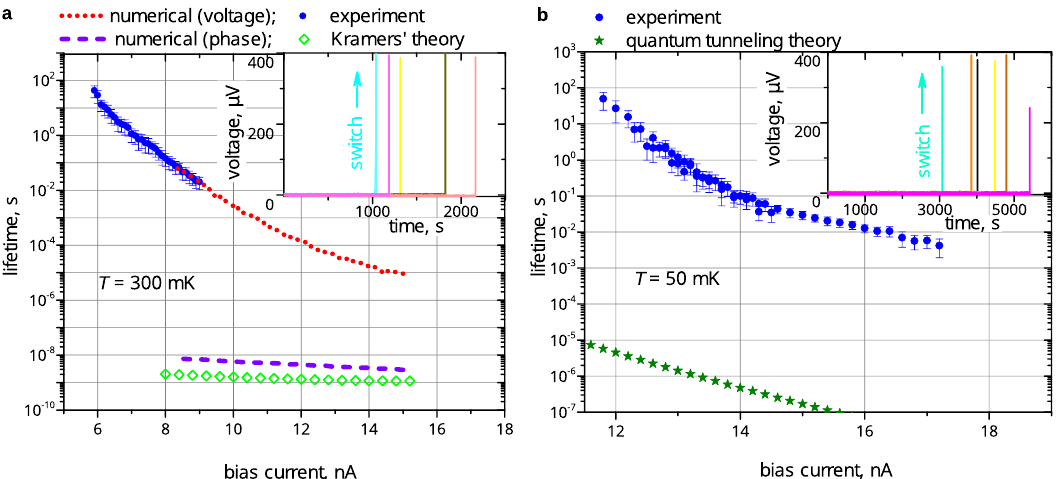
Fig. 2 The experimental and theoretical lifetime of the SIS junction versus bias current. a The temperature is 300 mK. Experiment (blue dots with error bars computed as standard errors) is compared with numerical results (red dots) of the voltage escape with account of multiple phase slips. The dashed violet curve is the numerical results of the phase escape across the barrier, the diamonds represent the corresponding Kramers' theory (1). The parameters are: I c = 23 nA, C = 46 fF, R N = 4200 Ω , T = 300 mK. Inset: Examples of voltage traces at I = 5 nA, when the SPC switches into the resistive state, showing the lifetime in the range from 1000 to 2200 s from trial to trial. b The temperature is 50 mK. Experiment is given by blue dots with error bars computed as standard errors. The green stars represent the quantum tunnelling theory from 32 . Inset: Examples of voltage traces at I = 11 nA, when the SPC switches into the resistive state, showing the lifetime in the range from 3000 to 5500 s from trial to